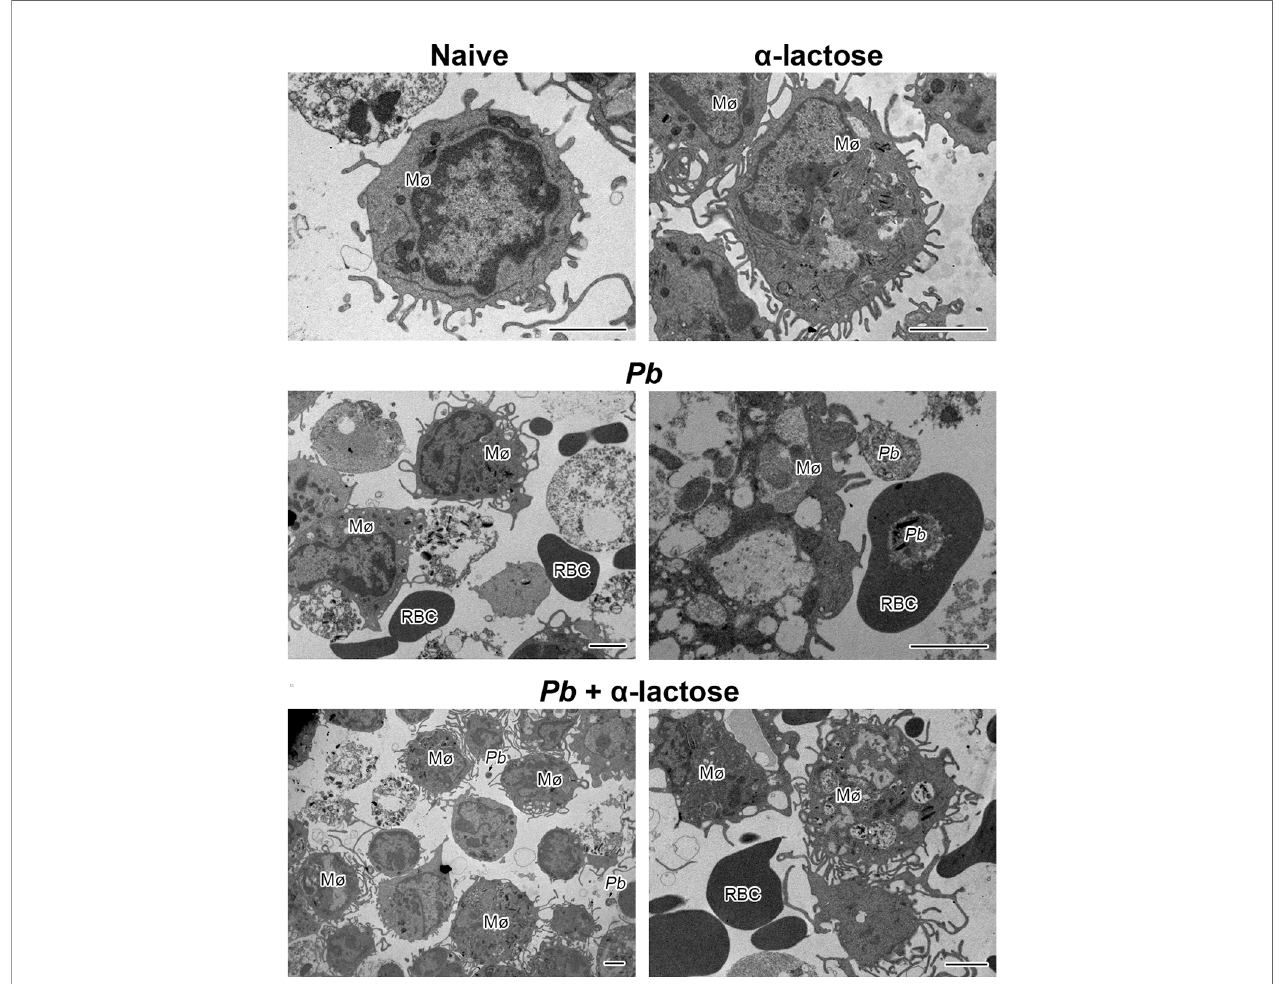
FIGURE 7 | The ultrastructures of peritoneal macrophages from Pb ANKA-infected mice with or without a -lactose treatment. Mø, peritoneal macrophage; RBC, red blood cell; Pb , P. berghei . Bar = 2 m